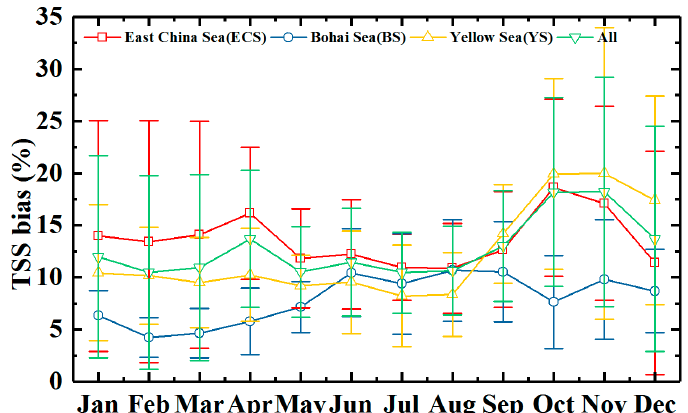
Figure 7. Changes of monthly bias for TSS in China’s seas from GOCI observations.